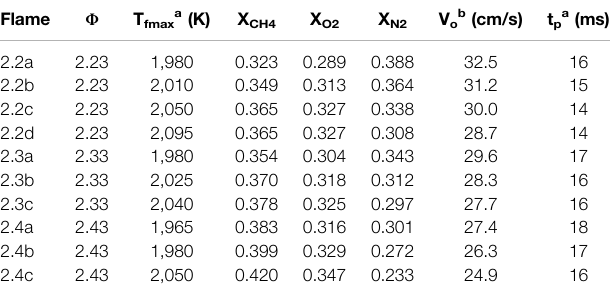
TABLE 1 | Summary of fl ame conditions currently